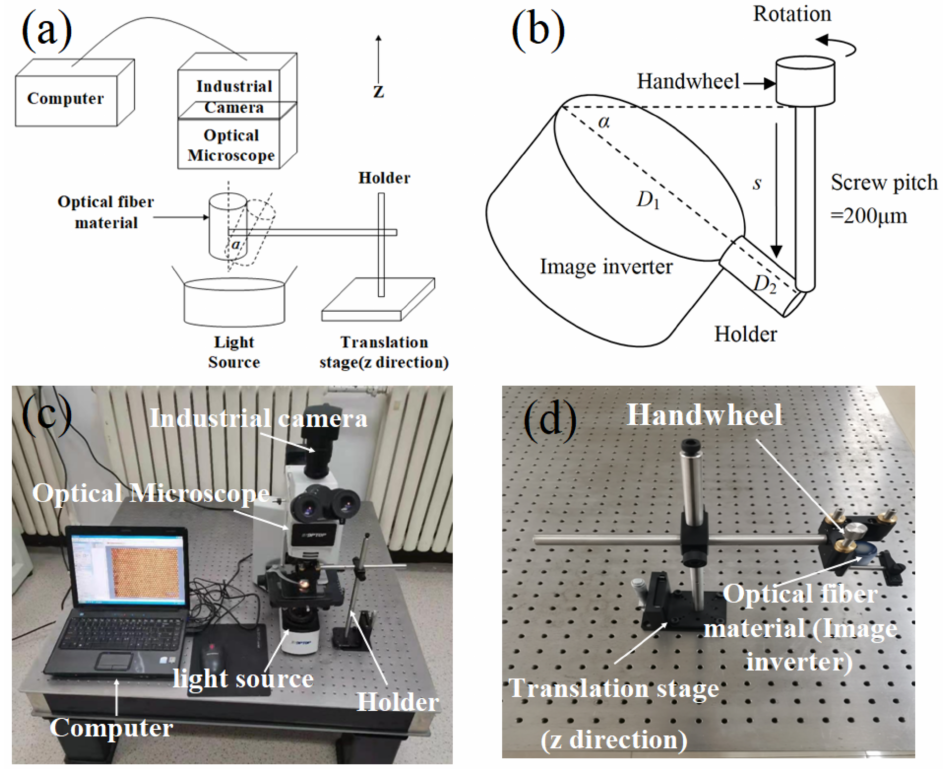
Figure 4. Experimental setup and schematic diagram: ( a ) measurement schematic; ( b ) relation between loading deformation and α ; ( c ) setup diagram; ( d ) holder and